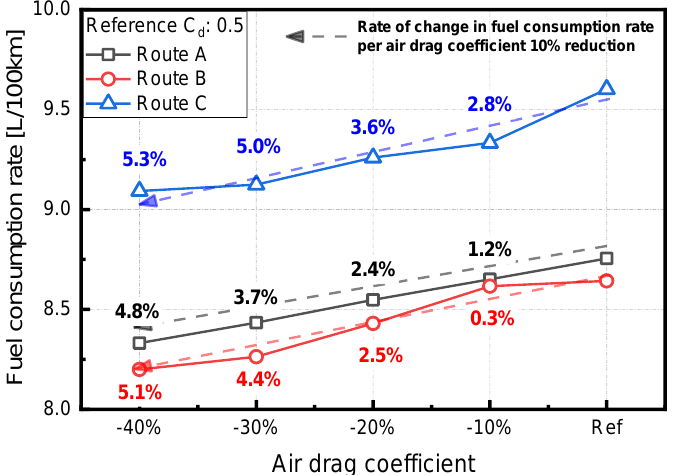
Figure 8. Fuel consumption rate with respect to air drag coefficient.